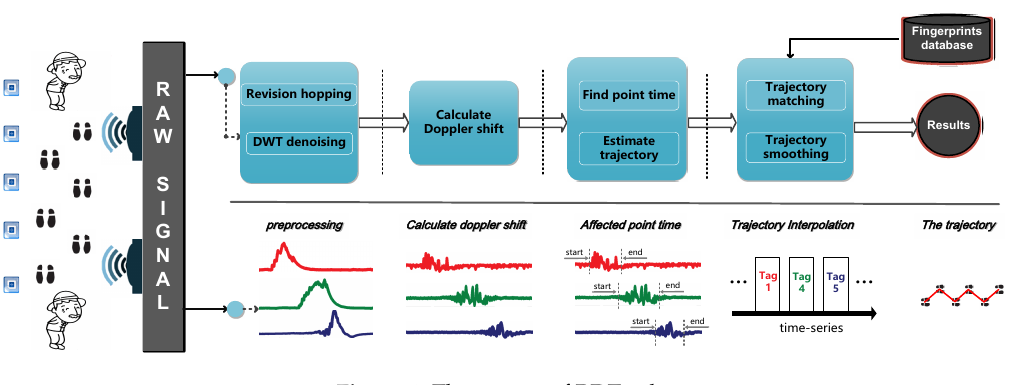
Figure 4. The system of